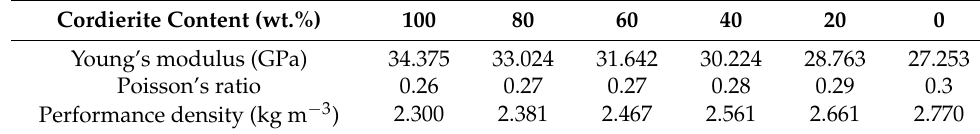
Table 2. Core elastic parameters of different cordierite contents.